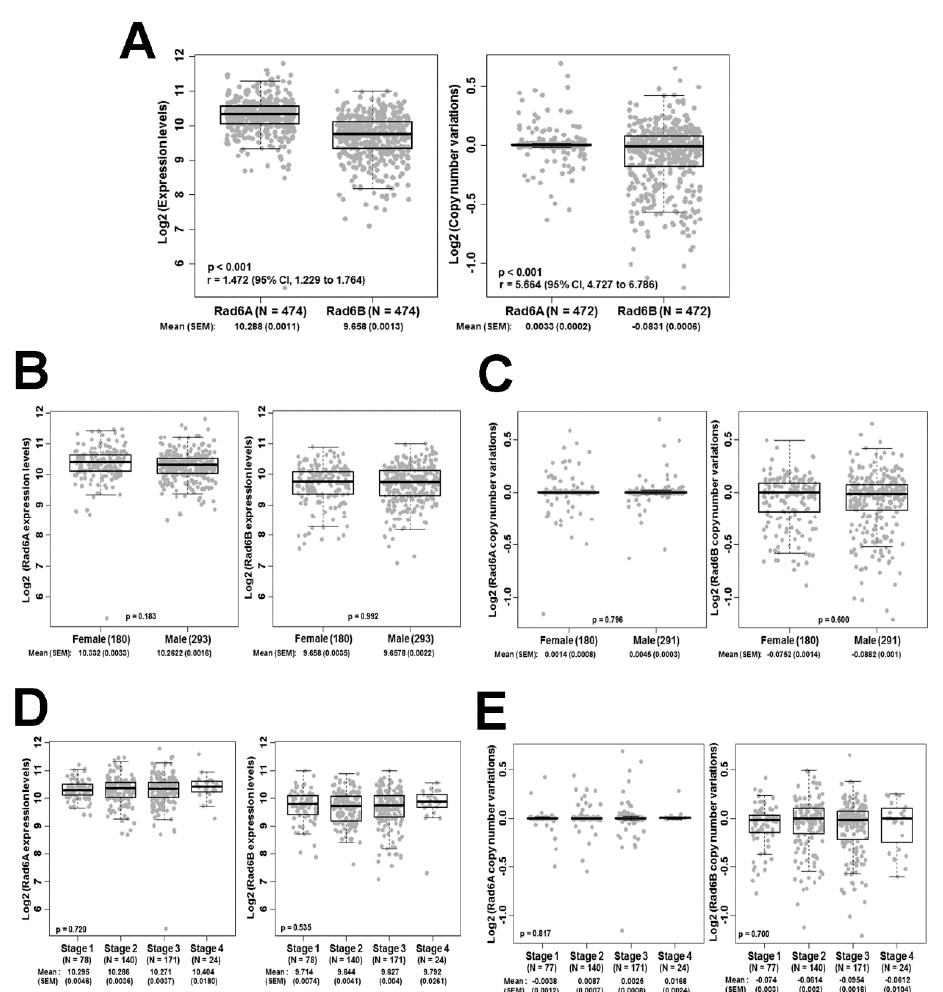
Figure 1. TCGA analysis of RAD6A and RAD6B expression levels and copy number variations in cutaneous melanoma patients. ( A ) The equality of variances between RAD6A and RAD6B was examined using an F-test, and the ratio of variances is represented by ‘r’ and 95% confidence interval. r > 1 indicates greater heterogeneity for RAD6B expression and copy number variations than RAD6A .